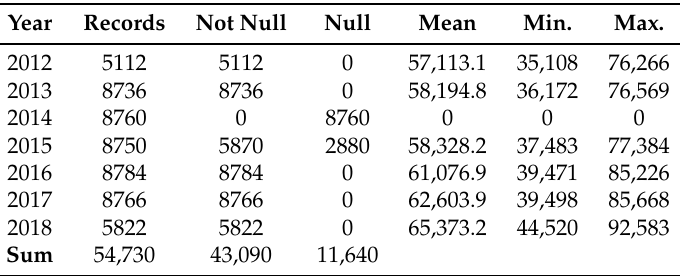
Table 2. Year wise data summary.